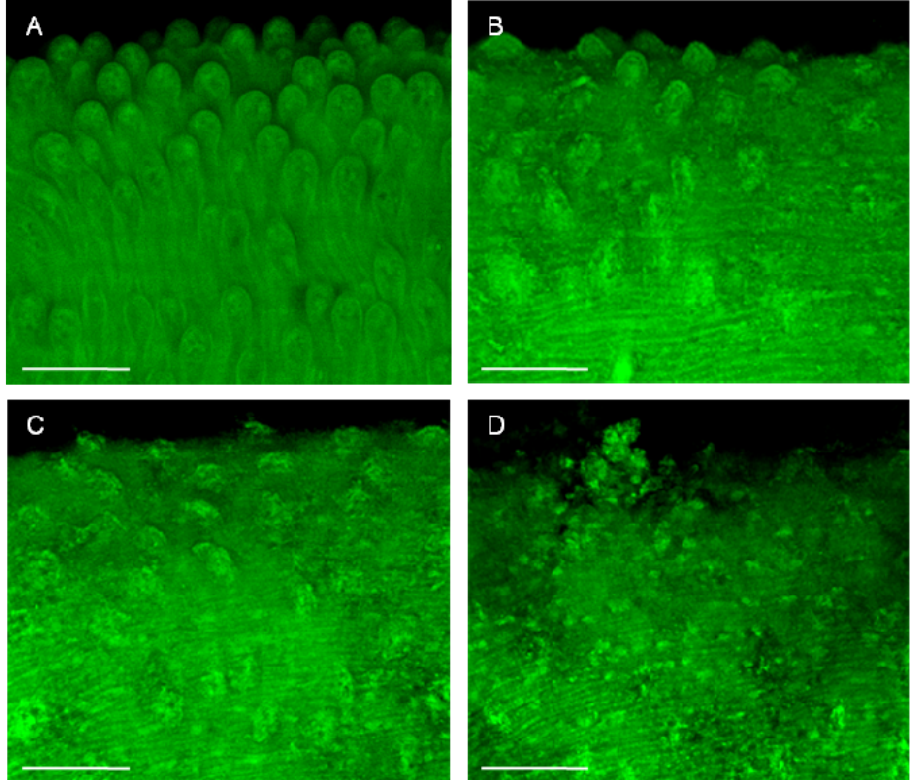
Figure 3. Microscopy investigation of Schistosoma mansoni male worm after in vitro incubation with nerolidol. After 5 days or in the case of death, schistosomes were fixed and monitored using a confocal microscopy. ( A ) Negative control. ( B ) 62.5 µM nerolidol. ( C ) 125 µM nerolidol. ( D ) 250 µM nerolidol. Scale bars = 50